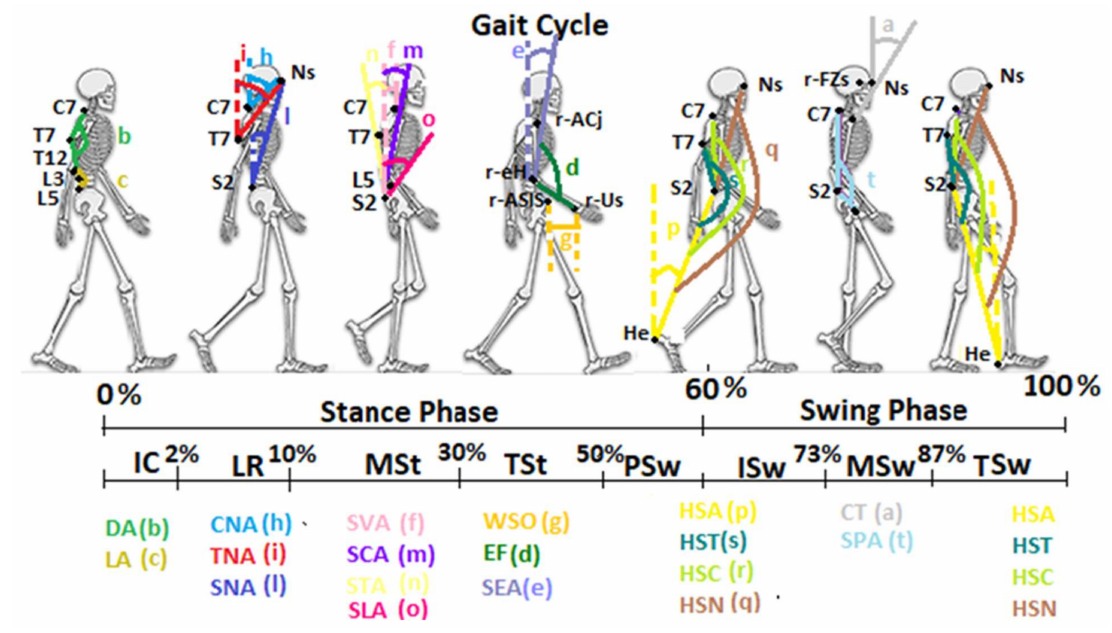
Figure 3. Graphic representation of the new sagittal DB-Total parameters during the different phases of the gait cycle. Initial contact (IC), loading response (LR), mid-stance (MSt), terminal stance (TSt), pre-swing (PSw), initial swing (ISw), mid-swing (MSw), terminal swing (TSw), nasion (Ns), heel (He), sacrum (S2). The acronyms and the colors of the parameters are the same as those mentioned in Figure 1. Vertical axes are represented as dashed